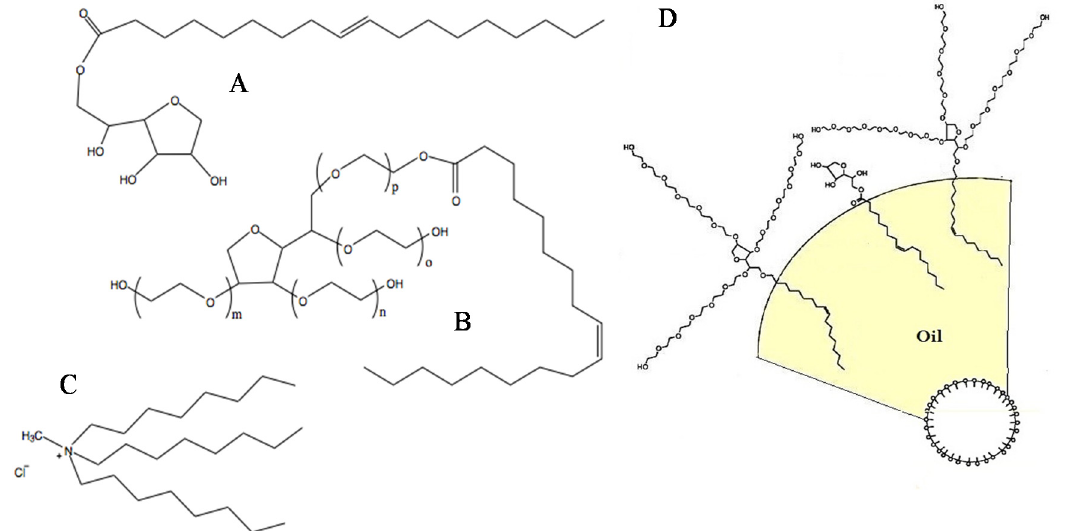
Figure 2. The structural formula of A : Span 80 (sorbitan monooleate); B : Tween 80 (ethoxylated sorbitan monooleate); and C : TOMAC (tri- n -octylmethylammonium